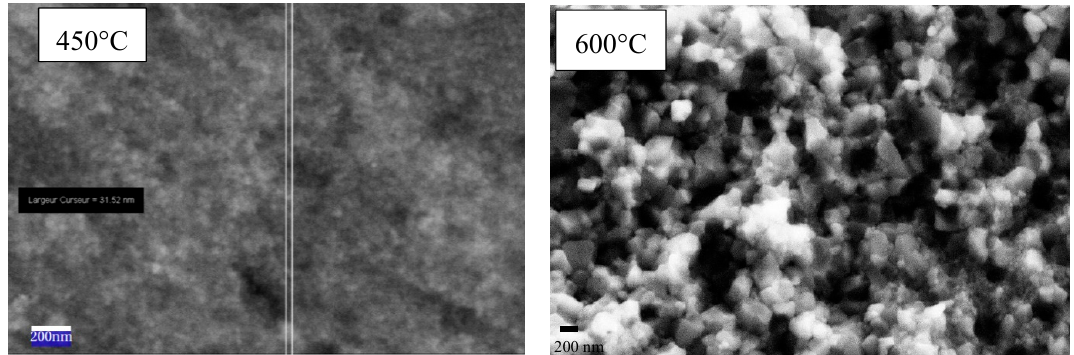
Figure 9. SEM images of niobium-doped TiO 2 after SPS at 400 MPa in a WC matrix. The influence of phase transition on grain size is clearly visible in the SEM images .